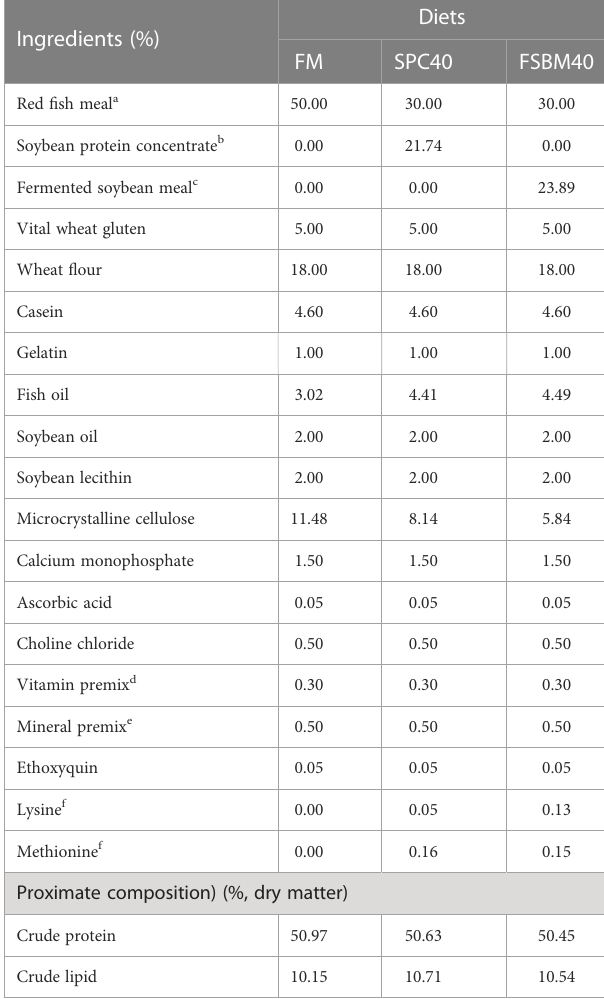
TABLE 1 Formulation and proximate composition of the experimental diets (%, dry